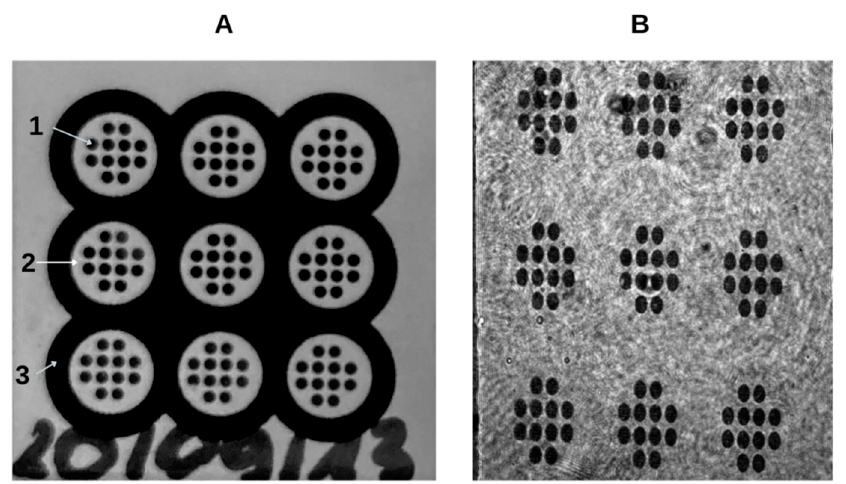
Figure A3. Diagram of the biosensor structure.